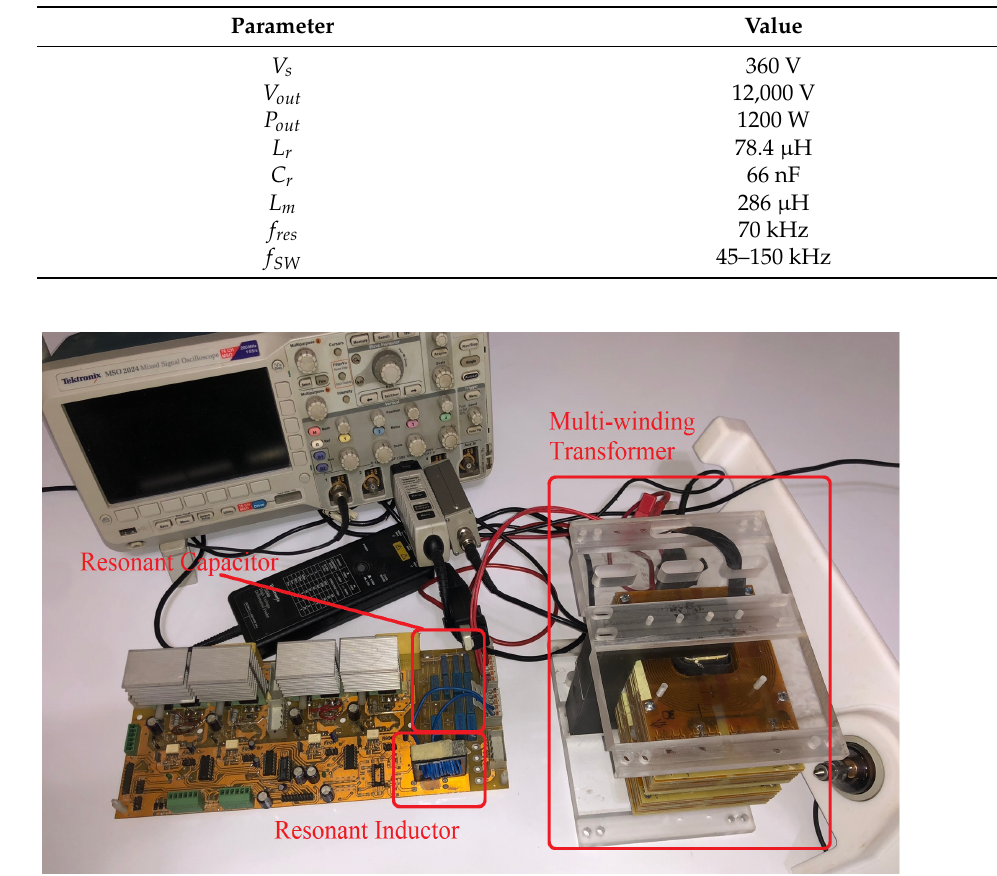
Figure 14. Test Setup.